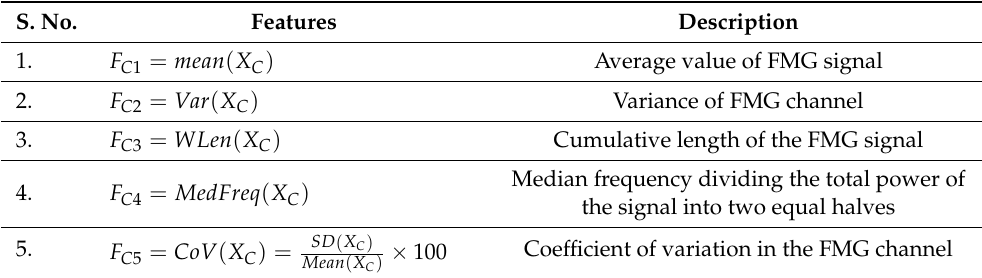
Table 1. Features extracted from the eight-channel FMG